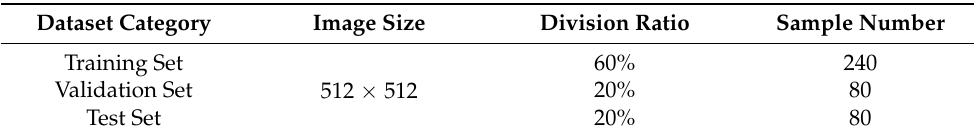
Table 1. Detailed information about the total number of images, their size and their division for training, validation and testing stages.